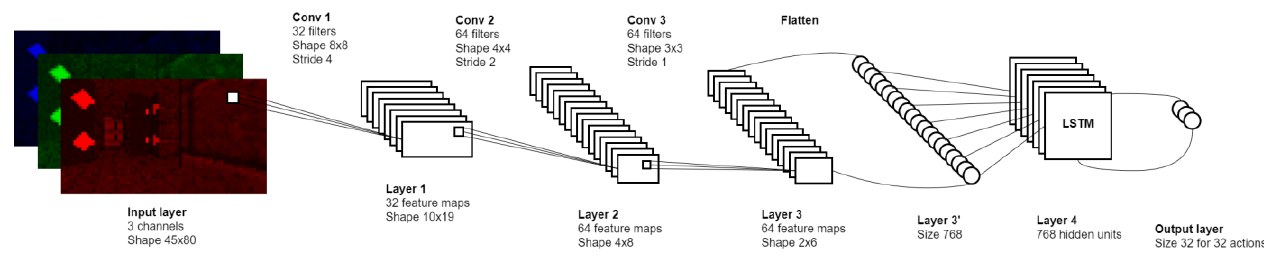
Figure 1 . The architecture of the neural network. The network takes a down-sampled RGB image as input and propagates it forward through three convolutional layers and an LSTM layer with 768 hidden units to output 32 action values. Layer 3’ is the neurons from layer 3 flattened into one vector of length